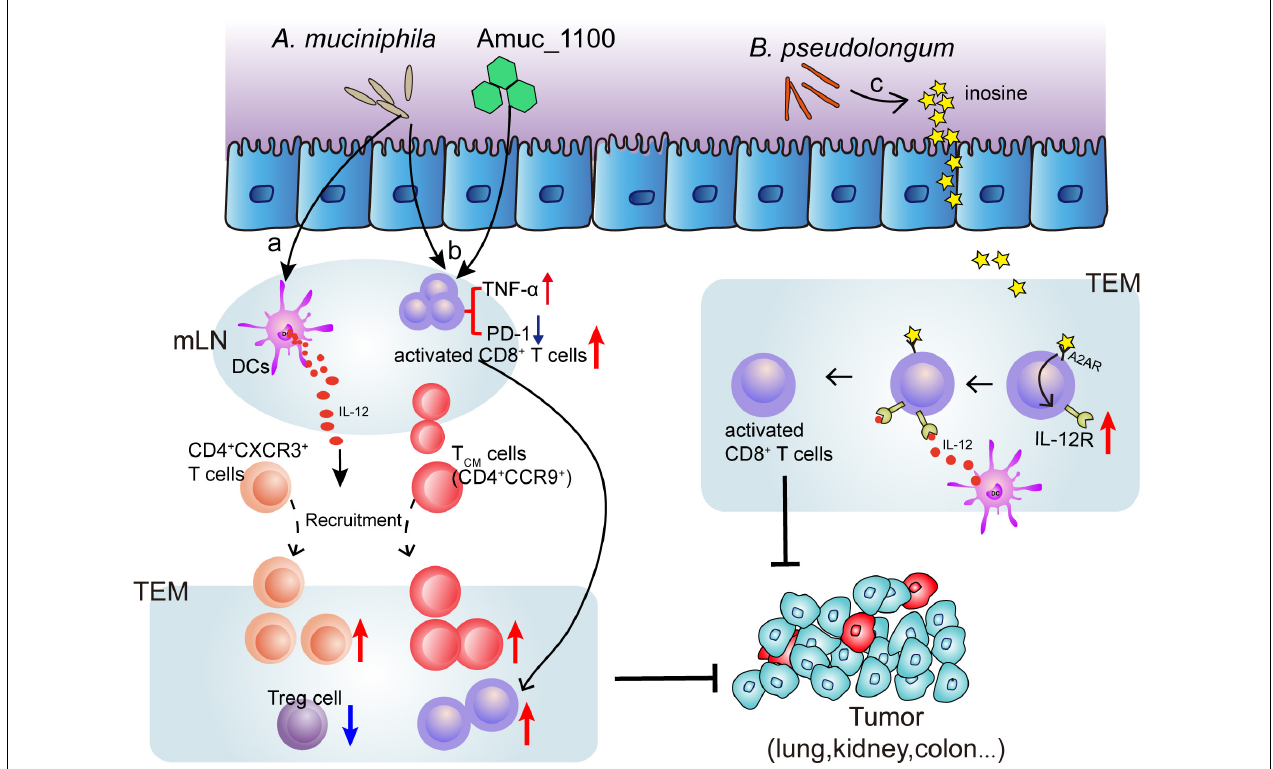
FIGURE 2 | Mechanism of bacteria ( Akkermansia muciniphila and Bifidobacterium pseudolongum ) induced ICB efficacy enhancement. (a) Oral supplementation with A. muciniphila accelerates IL-12 secretion by dendritic cells (DCs) leading to restoring the recruitment of CXCR3 + CD4 + and CCR9 + CD4 + T lymphocytes into tumor microenvironment (TEM), so that restoring the efficacy of PD-1 blockade. (b) A. muciniphila or a A purified membrane protein (Amuc_1100) from A. muciniphila treatment activates CD8 + T cells in mesenteric lymph nodes (mLN) and promote the recruitment of CD8 + T cells into TEM, representing by TNF- α upregulation and PD-1 downregulation. (c) Inosine, the metabolite from B. pseudolongum , co-stimulates A2A receptor (A2AR) leading to increased expression of IL-12 receptor on CD8 + T cells, which further increases the T cell